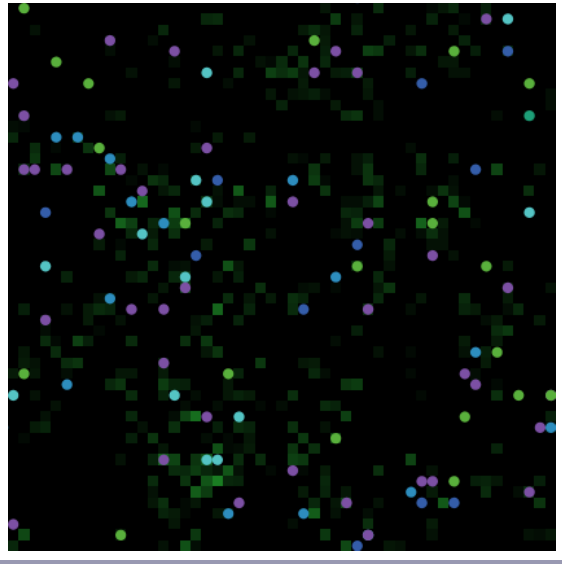
Fig. 3. Example of the state of the forest in the open- access model, representing the forest after 20,000 rounds. Green indicates the amount of tree biomass: darker patches indicate lower tree biomass; lighter patches indicate higher tree biomass. Black indicates complete removal of trees. Circles indicate loggers. In this case, the forest is almost completely